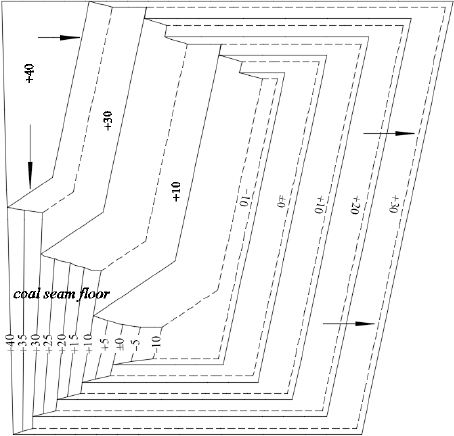
Fig. 9 Construction and devel- opment of internal dumps in anticline